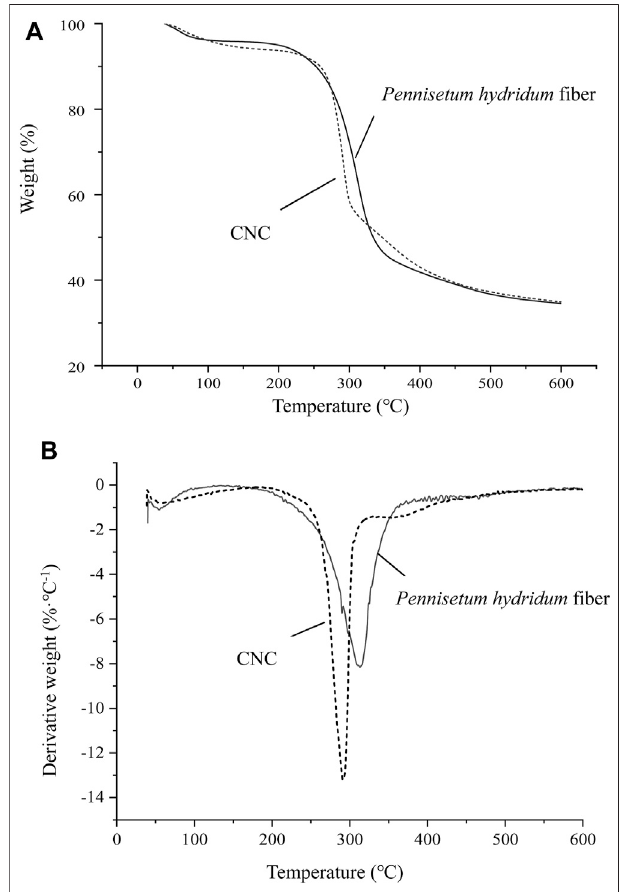
FIGURE7| TG (A) andDTG (B) curvesoftheCNCpreparedatRT,65% wt, and 120 min and deligni fi ed Pennisetum hydridum fi ber.